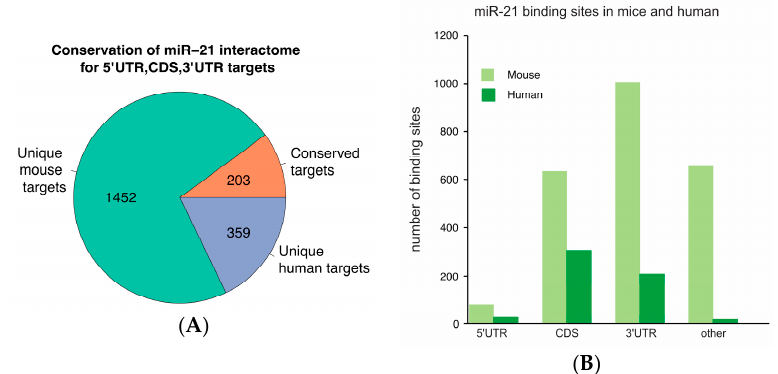
Figure 3. A low number of miR-21 sites are conserved among mice and humans. Targets in human livers or HCCs that precipitated miR-21 in Ago-CLIP (GSE97061) were compared to homolog gene identifiers from Ago-CLIP in mouse liver (GSE97058). Targets contained at least one binding site for miR-21 in the 5’UTR, CDS or 3’UTR ( A ). The number of binding sites at different locations in the mouse and human transcriptomes was compared ( B ).